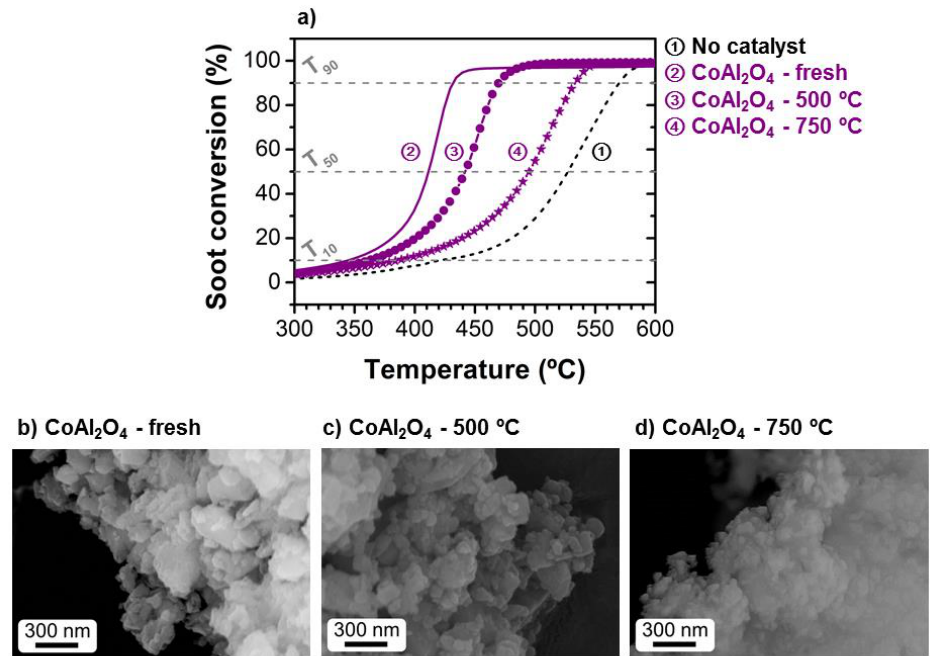
Figure 5. ( a ) Soot combustion profiles of CoAl 2 O 4 sample—fresh (solid line) and after first use for soot combustion up to 500 °C (circles) or 750 °C (stars). The dotted line is the reference non-catalyzed soot combustion experiment. Bottom (b-d): FESEM micrographs of CoAl 2 O 4 ( b ) fresh sample, and reused after ( c ) 500 °C or ( d ) 750 °C.